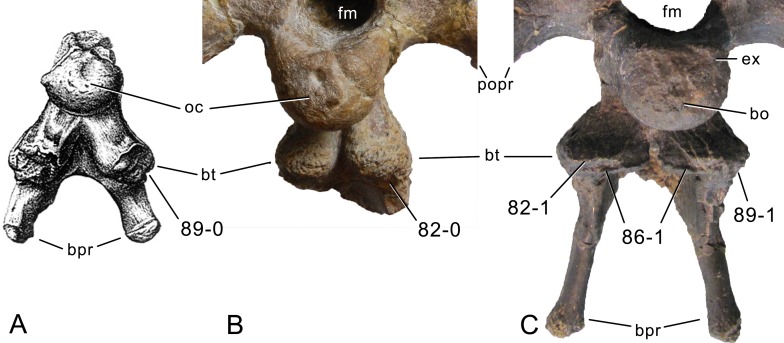
Neosauropod basal tubera.Basal tubera of Camarasaurus grandis YPM 1905 (A; modified from Madsen, McIntosh & Berman, 1995), Suuwassea emilieae ANS 21122 (B), and Kaatedocus siberi SMA 0004 (C; photo by J Marinheiro) in posterior view. Note the globose (B; C82-0) compared to the box-like shape (C; C82-1) of the tubera, the transverse ridge on their posterior face (C; C86-1), and the ventrolateral (A; C89-0) in contrast to ventral orientation (C; C89-1). Abb.: bo, basioccipital; bpr, basipterygoid process; bs, basisphenoid; bt, basal tuber; ex, exoccipital; fm, foramen magnum; oc, occipital condyle; popr, paroccipital process. Pictures scaled to same distance between dorsal face of occipital condyle and basal tubera.